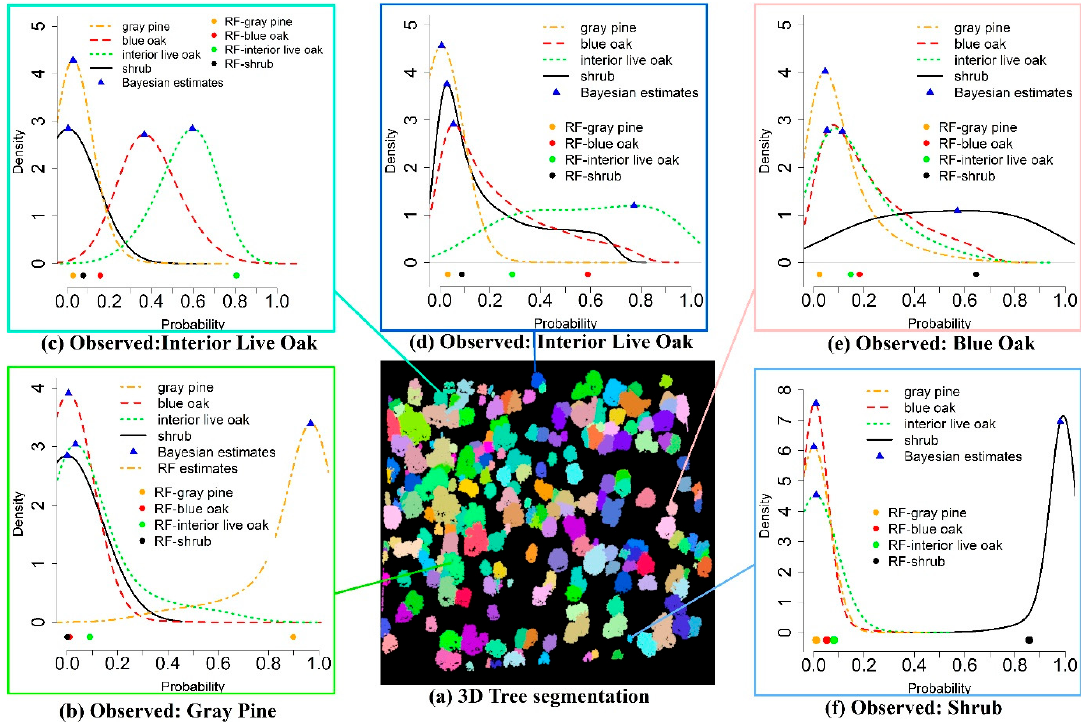
Figure 6. Examples of tree species classification using the RF and BMLR methods with testing data.